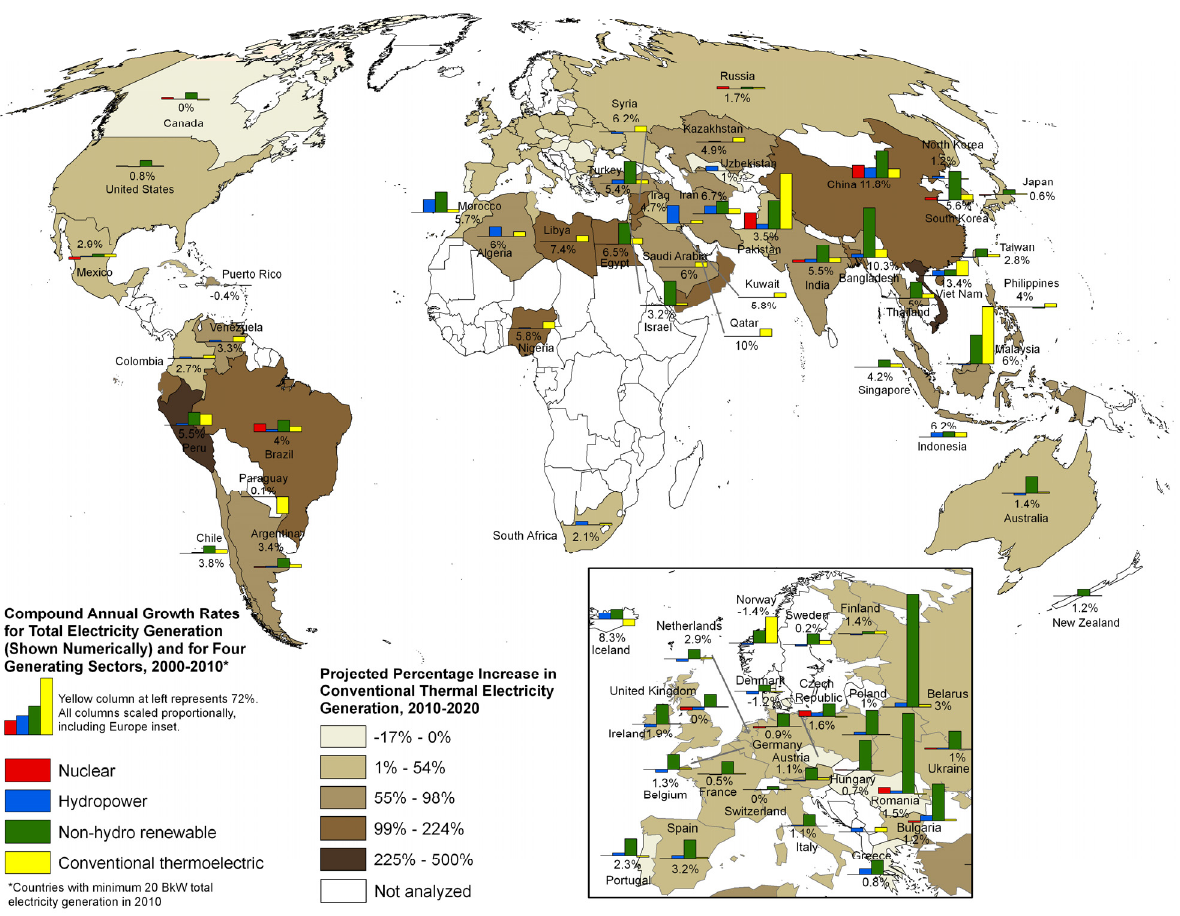
Figure 1. Growth in electricity generation by country (total, nuclear, hydropower, non-hydropower renewable, and conventional thermal), 2000–2010; and percentage increase in conventional thermal electricity generation,